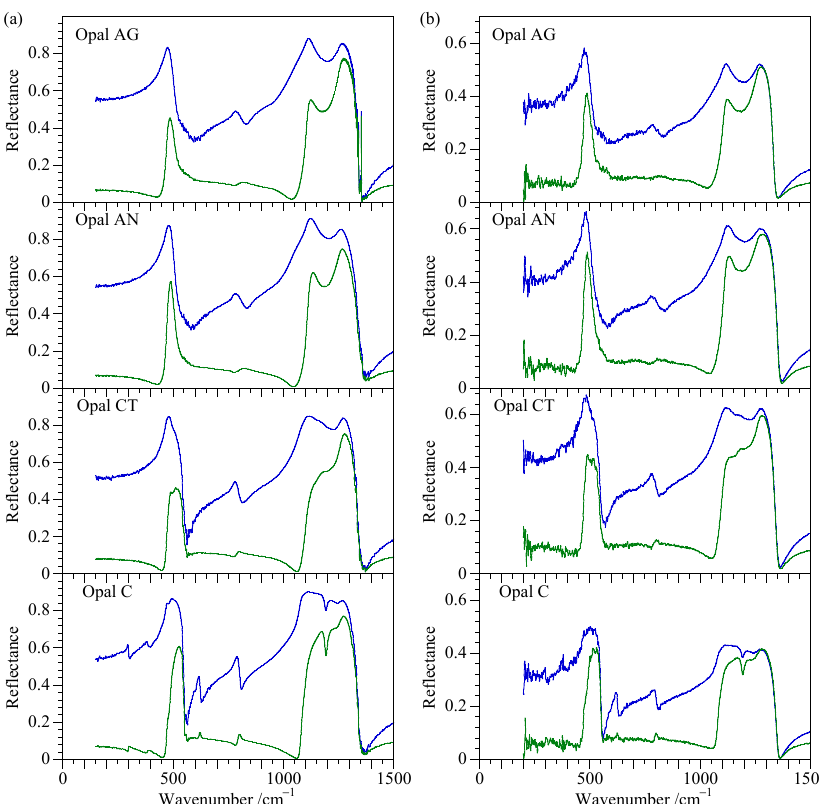
Minerals 2021 , 11 , x 14 of 32